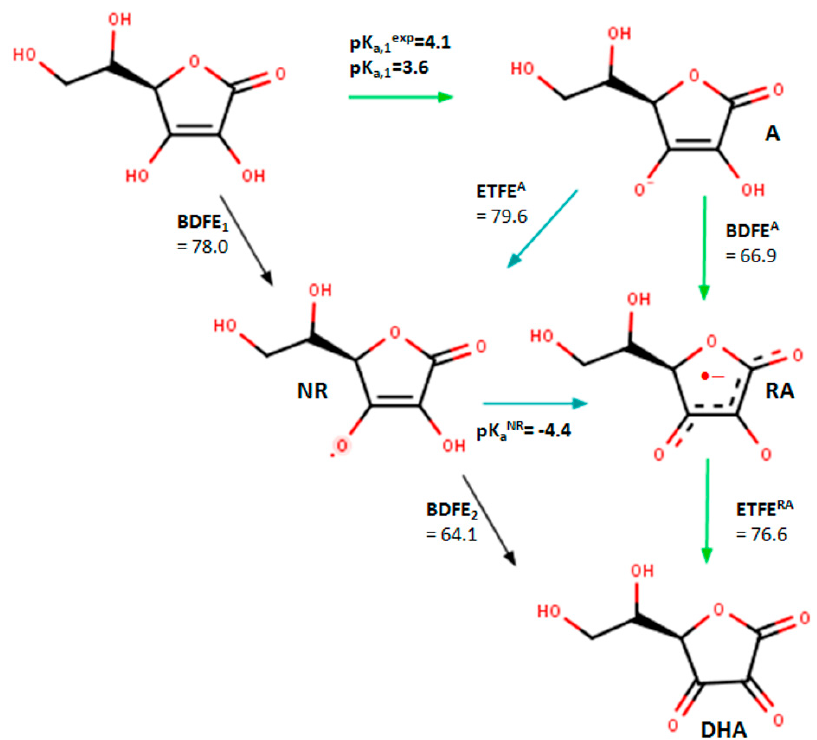
Figure 2. Radical scavenging mechanisms and associated calculated aqueous free energies (bond dissociation free energy (BDFE) and electron transfer free energy (ETFE) in kcal/mol) and negative logarithm of acid dissociation constant for the most acidic OH group, pKa,1, Table 2), of L-ascorbic acid (L-ASA) at physiological pH. The ascorbate anion deprotonated at the O -3 position may neutralize a free radical by the donation of an H-atom (green pathway) or an electron (cyan pathway). The intermediate radical anion transforms to the final product, dehydroascorbic acid (DHA), by further giving an electron. The synthesized L-ASA derivatives may follow the same radical scavenging mechanisms.